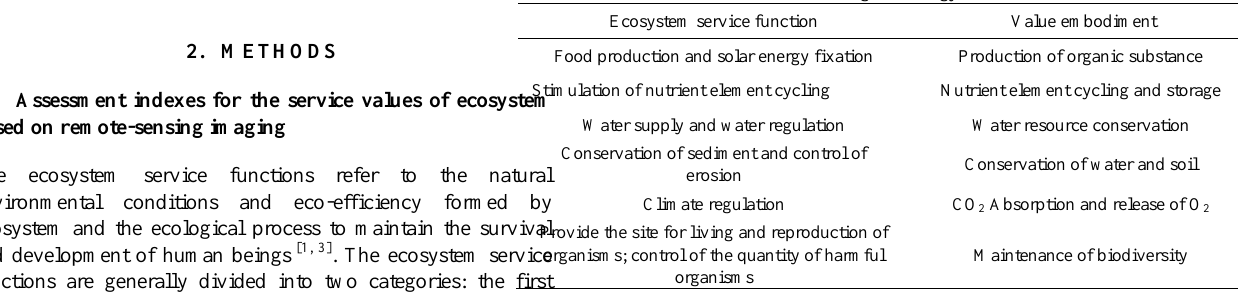
Table 1 Evaluation index of ecosystem services value based on remote sensing